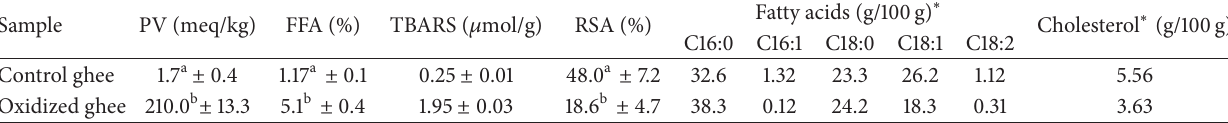
Table 2: Effects of coadministration of unoxidized and oxidized desi ghee on the body, kidneys, liver, and heart weight of rabbits. Group Control